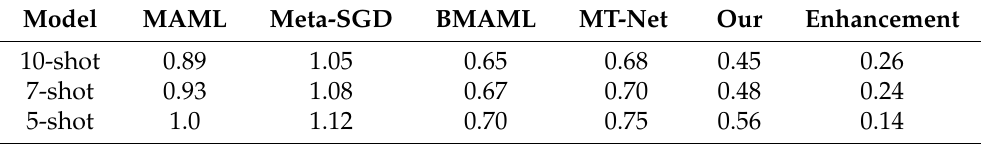
Table 1. Comparison of experimental error (mean square error with 95% confidence) results between the task-covariant meta-learning algorithm and other meta-learning algorithms in 2D regression tasks.